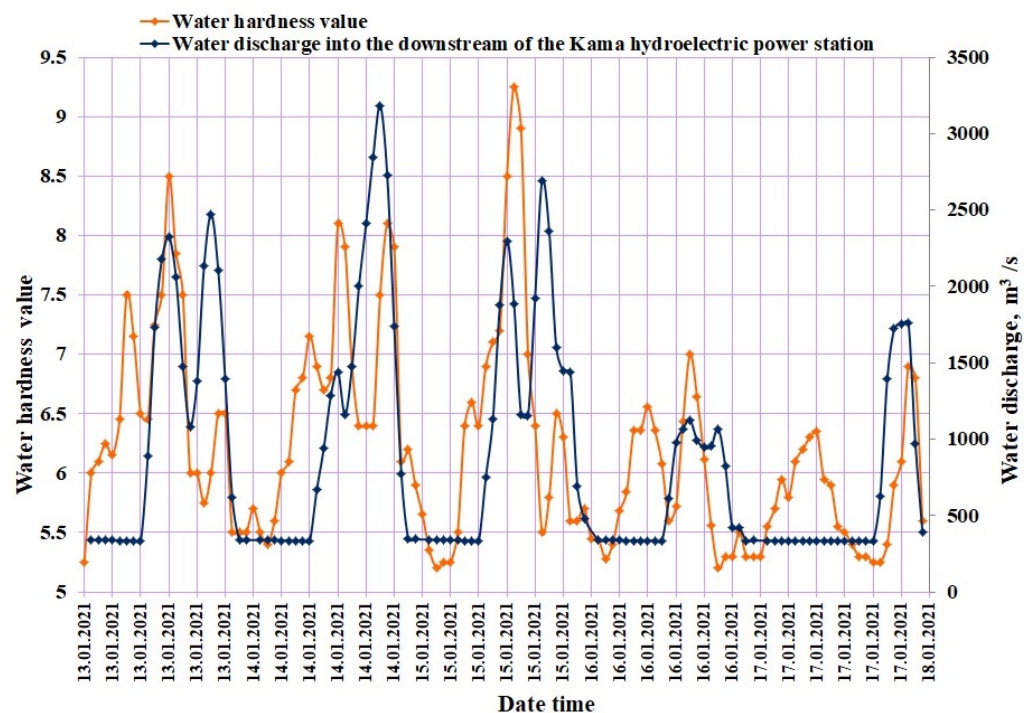
Figure 3. Superimposed graphs of the flow rate of water discharge through the Kamskaya HPS and the values of electrical conductivity in the intake chamber of the Chusovskoy water intake of Perm city (for the period of 13 January 2021–18 January 2021).